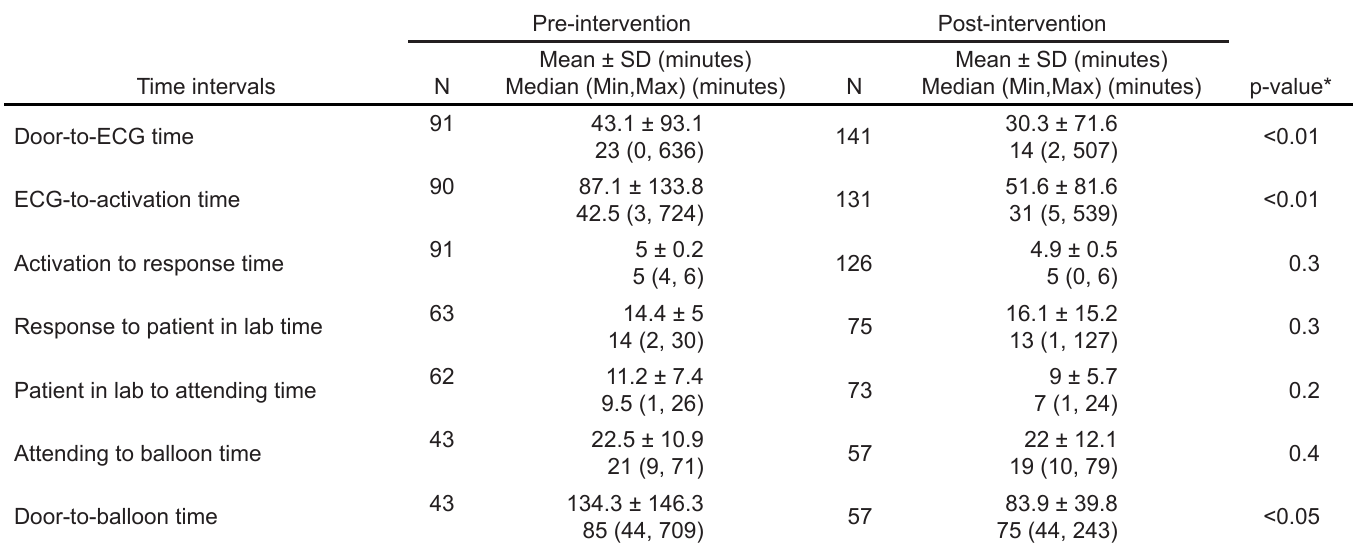
STEMI, ST segment elevation myocardial infarction; ECG, electrocardiogram *Obtained from Wilcoxon rank-sum